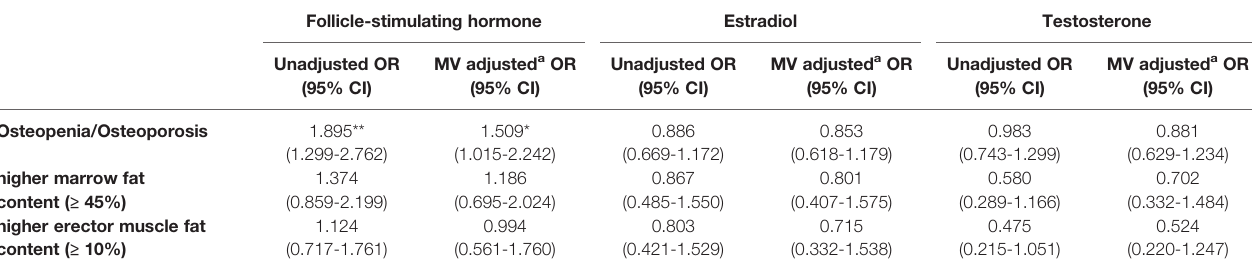
TABLE 4 | OR of osteopenia/osteoporosis, higher marrow fat, and higher muscle fat (erector muscle fat content ≥ 10%) per SD increase in FSH, estradiol, and testosterone concentrations in